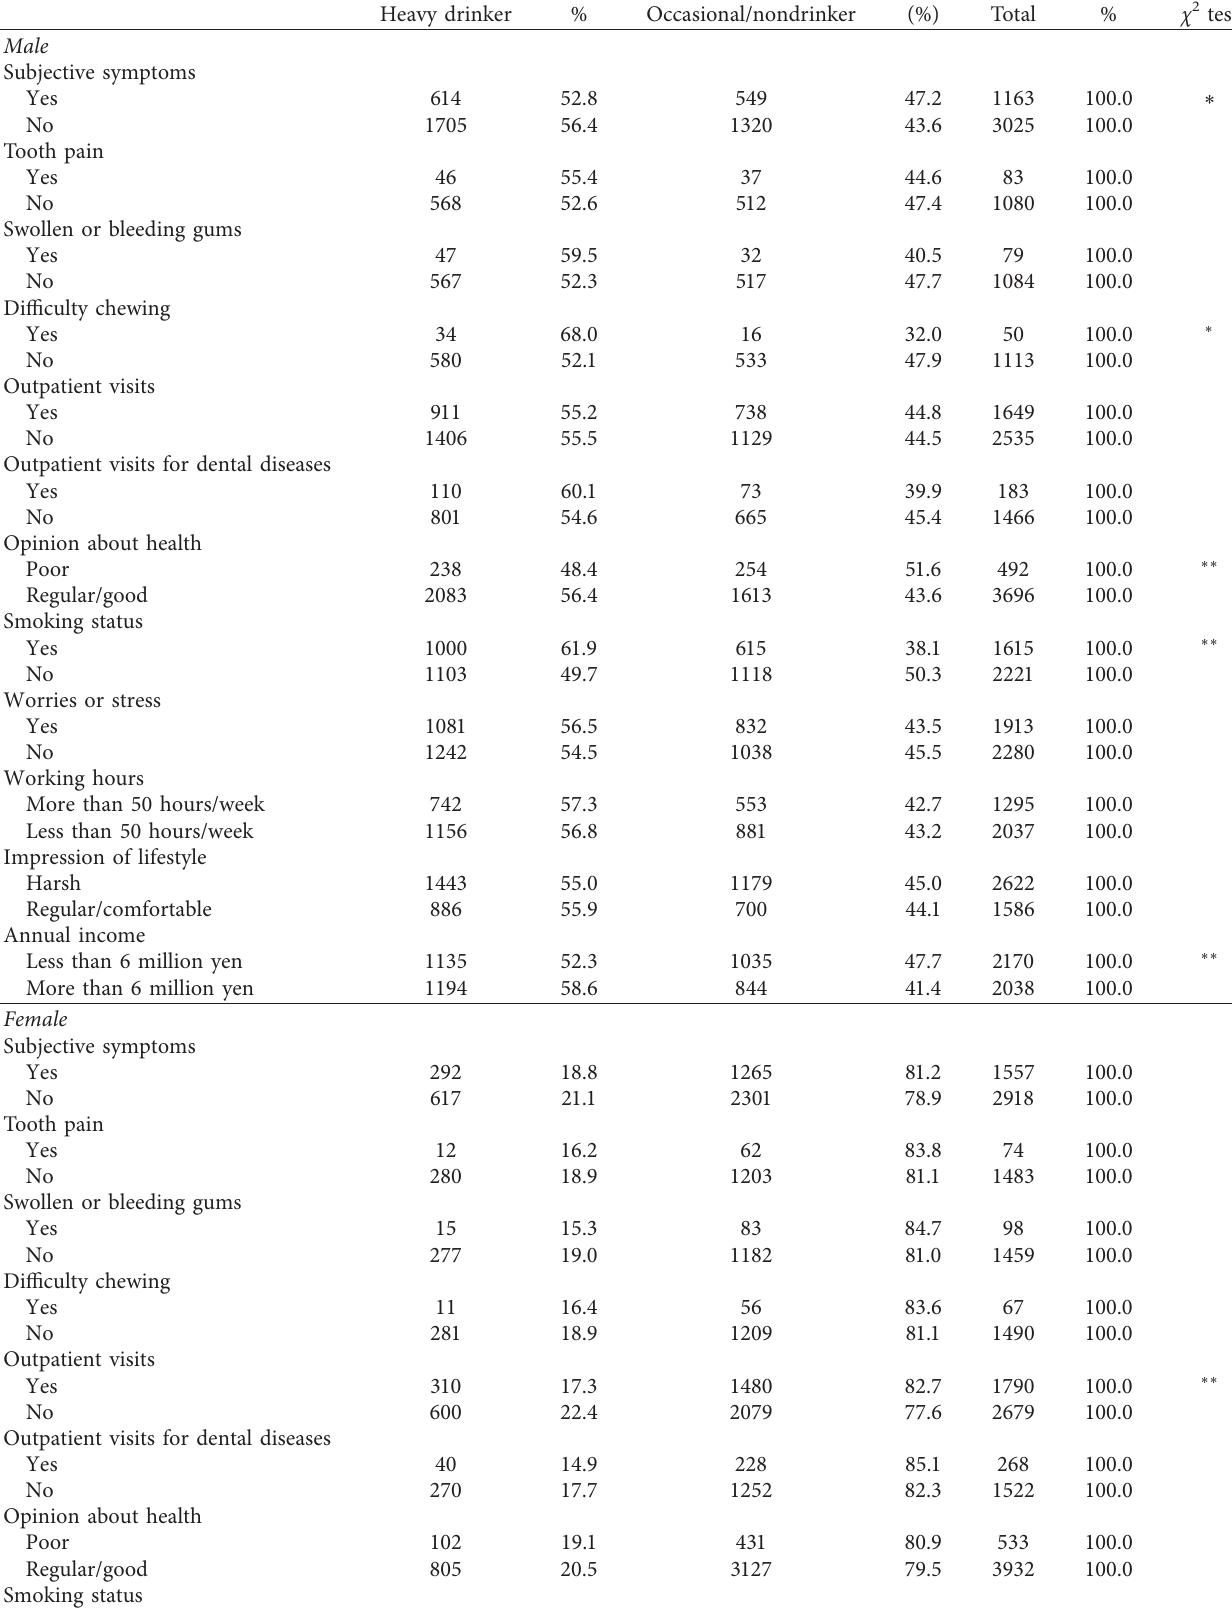
Table 3: Questionnaire responses stratified by drinking